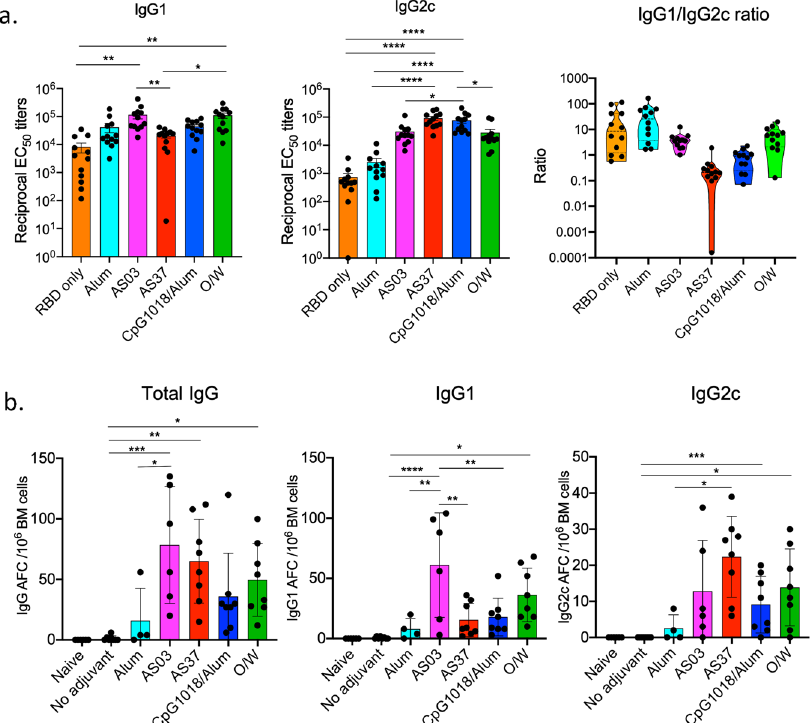
Fig. 2 Bone marrow plasma cell responses to immunization with RBD-NP and adjuvants. a Anti-spike protein IgG1 and IgG2c titers in serum measured at day 28 post-immunization. Right panel represents ratio of IgG1 to IgG2c titers. b Pooled ELISPOT results from 2 independent experiments with n = 4 mice per experiment. Total IgG, IgG1, and IgG2c-producing bone marrow plasma cells were quanti fi ed at day 33 post-immunization. P -values: * denotes p < 0.0332, ** p < 0.0021, *** p < 0.0002, and **** p < 0.0001. Error bars indicate mean ± SEM in all